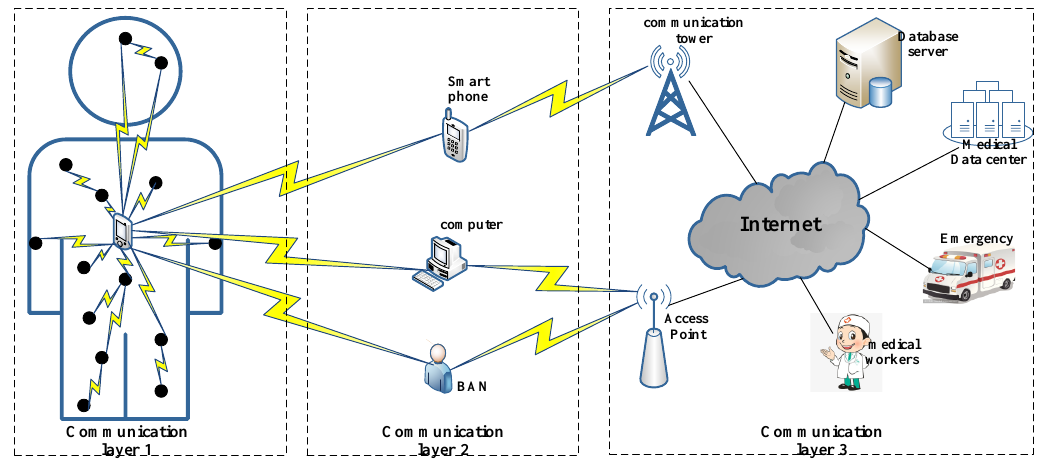
Figure 1. Architecture of wireless body area network communication.